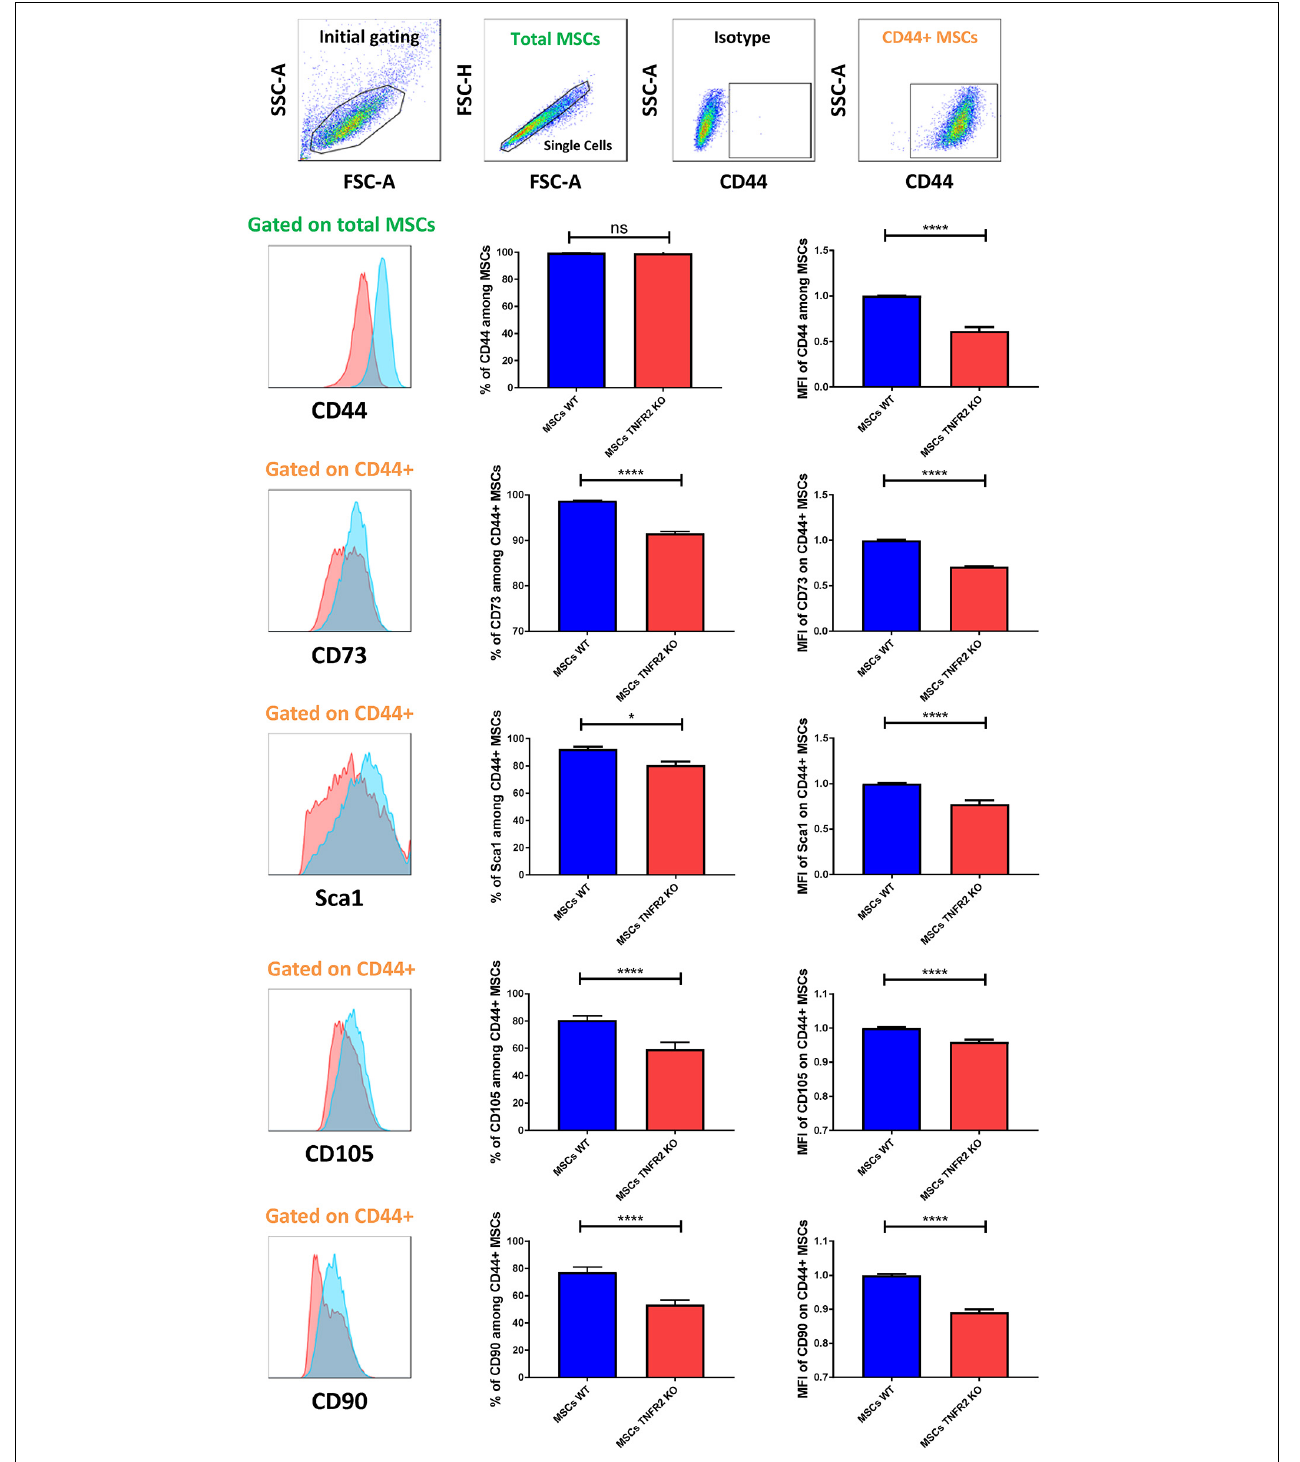
FIGURE 2 | Mesenchymal stem cell (MSC) characteristic markers’ expression is diminished in the absence of TNFR2. This figure illustrates the surface expression of mouse MSC markers such as CD44, CD73, stem cell antigen-1 (Sca1), CD105, and CD90 in both MSC types (P3). To investigate the expression level of CD44 marker, cells were pre-gated on total MSCs (represented in green color). For the rest of the markers, cells were pre-gated on CD44 + MSCs (represented in orange color). Mean fluorescence intensity (MFI) values have been normalized with wild-type (WT)-MSC group. Red histograms depict TNFR2 knockout (KO)-MSCs, and blue histograms depict WT-MSCs. The results of CD44 ( n = 25) and Sca1 ( n = 19) expression are collected from four different experiments. The results of CD73, CD105, and CD90 markers ( n = 13) are collected from three independent experiments.